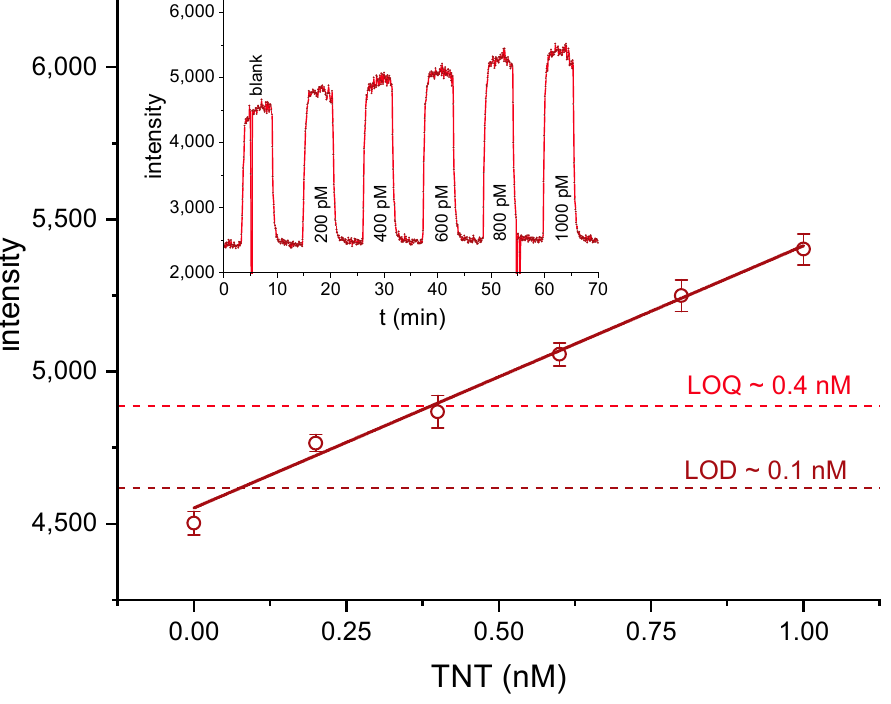
Figure 7. Biosensor measurements of TNT solutions in the range from 0 to 1 nM with a linear fit. LOD (3s) and LOQ (10s) were determined as 0.1 nM (20 ppt) and 0.4 nM (90 ppt). Error bars refer to the standard deviation based on subsequent frames. The biosensor signal is shown above.